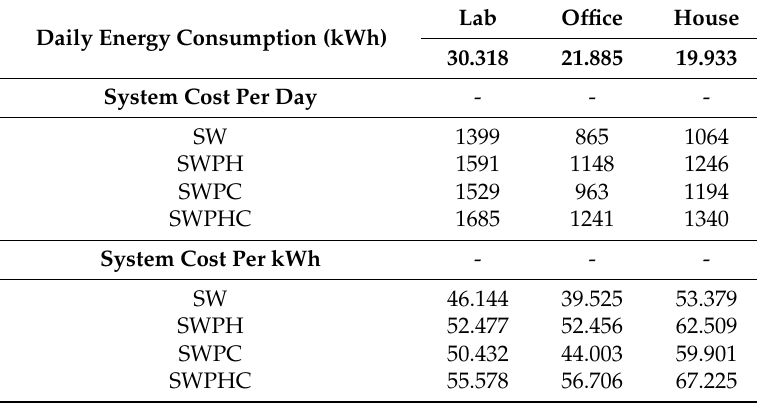
Table 3. Optimal system costs.